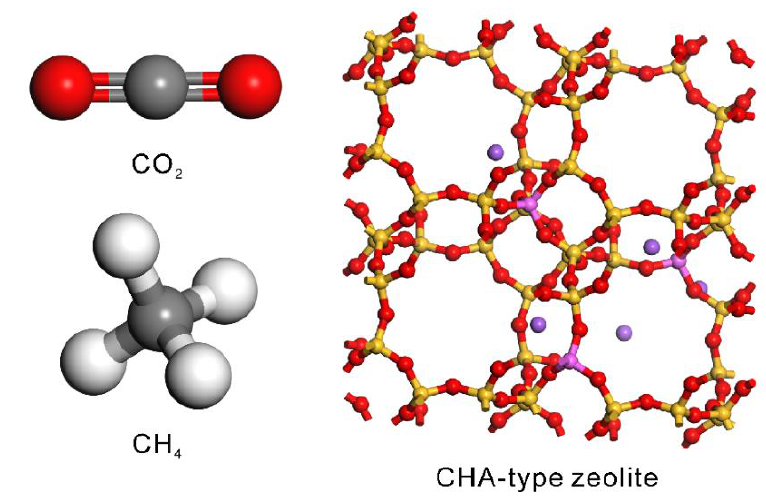
Figure 2. Atomistic models of CO 2 , CH 4 , and CHA-type zeolite used in this study. Table 1. Nonbonding interaction parameters of CH 4 , CO 2 , and zeolite.